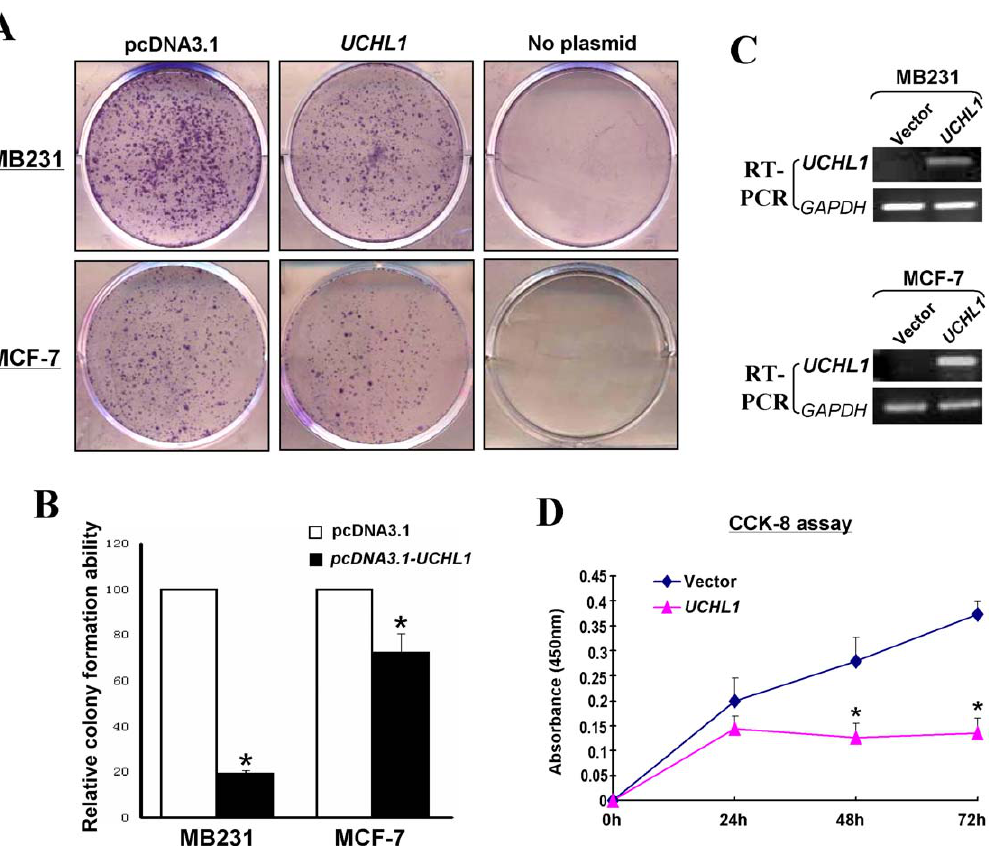
Figure 4. Effects of UCHL1 on the colony formation and cell proliferation of breast cancer cells. (A) Representative colony formation assay. (B) Quantitative analysis of colony formation. The numbers of G418-resistant colonies in vector-transfected controls were set to 100%. Values are expressed as mean 6 SD from three experiments, and the asterisks indicate statistical significance compared to controls ( p , 0.01). (C) Expression of UCHL1 by RT-PCR in vector- and UCHL1-transfected MB231 and MCF-7 cells. (D) CCK-8 cell proliferation assay for vector- and UCHL1-transfecetd MB231 cells. Asterisks indicate a significant level of proliferation compared to controls ( p , 0.05).